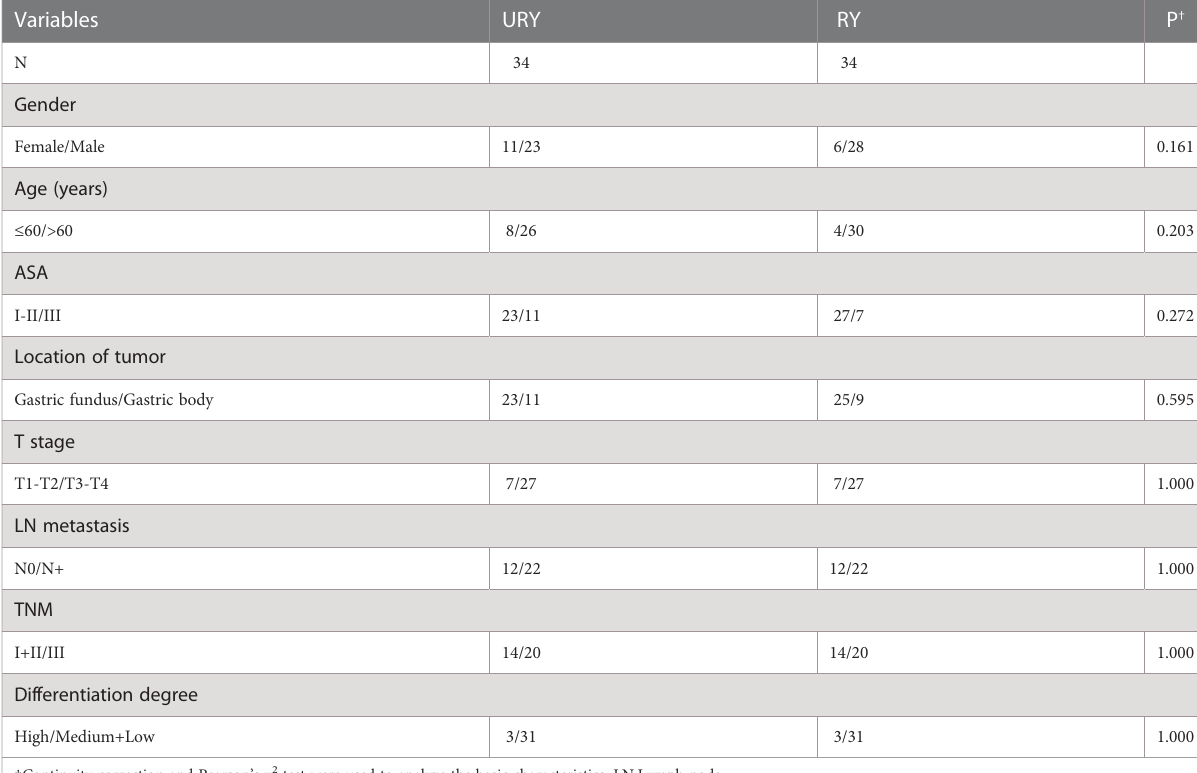
TABLE 4 Baseline characteristics of the including patients after PSM.